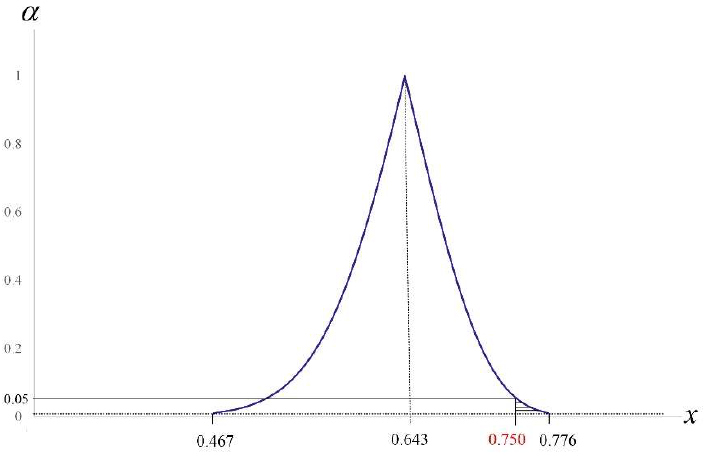
Figure 2. Membership functions η ( x ) with (cid:101) C Lm = ∆ ( C L , C M , C R ) = ∆ ( 0.467,0.643,0.776 ) and vertical line x =